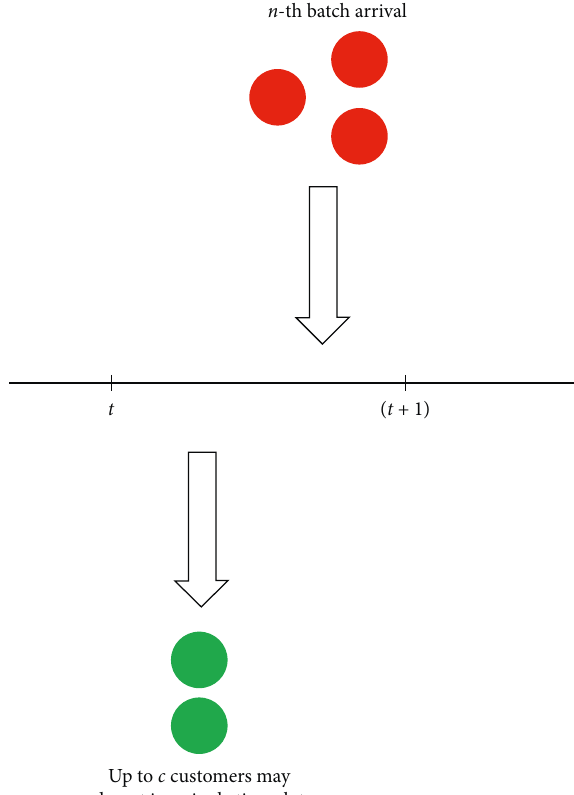
Figure 4: GI X / Geo / c with